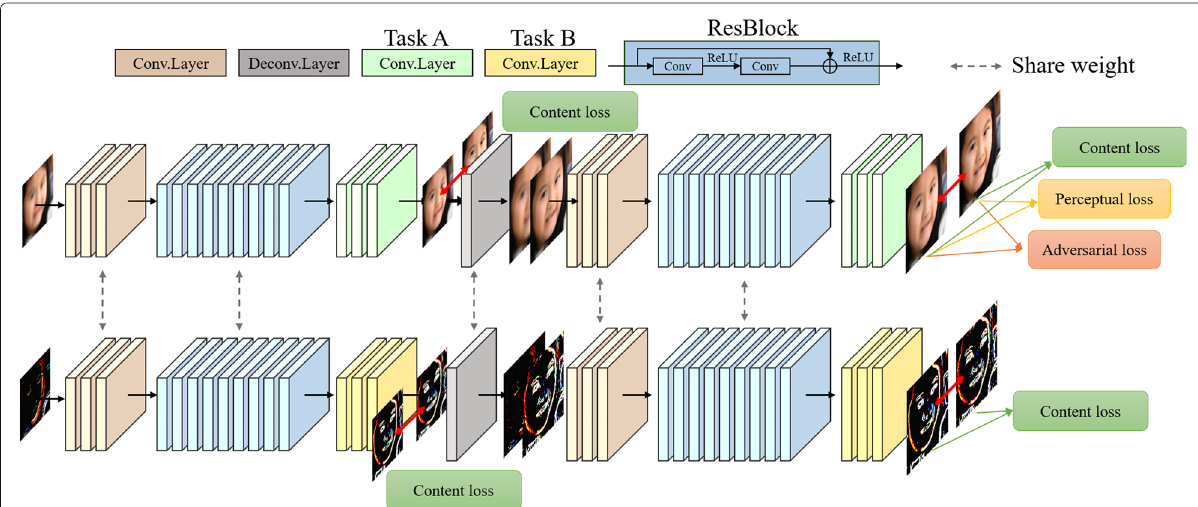
Fig. 2 Architecture of multi-task deblurring network. The network is designed as a multi-task framework; it contains a main branch and two sub-branches. The blur image and its corresponding structure first go through the main branch which shares parameters (with the same color in two branches) in image domain and structure domain. The feature of the image and the structure will be fed into different sub-network to achieve the reconstruction in different domain. In this multi-scale network, the coarse deblurring result will be merged with the original blur one and fed in to the following scale. The output of the network will be a finer deblurred